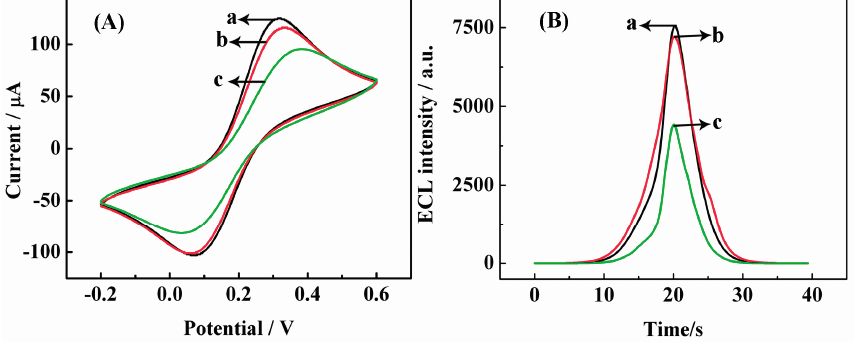
Figure 3. Verification of RCA and formation of hemin/G-quadruplex. ( A ) CVs at the (a) TRA/HT/SH-CP/AuE; (b) PP/TRA/HT/SH-CP/AuE; (c) RCA/PP/TRA/HT/SH-CP/AuE in the presence of 10.0 fM target DNA, were detected in 0.1 M KCl containing 1.0 mM [Fe(CN) 6 ] 3 − /4 − via scanning the potential from − 0.2 to 0.6 V at a scan rate of 50 mV·s − 1 ; ( B ) ECL responses of differently modified electrode: (a) PP/TRA/HT/SH-CP/AuE in the presence of 10.0 fM target DNA; (b) hemin/RCA/PP/TRA/HT/SH-CP/AuE in the absence of target DNA; (c) hemin/RCA/PP/TRA/HT/SH-CP/AuE in the presence of 10.0 fM